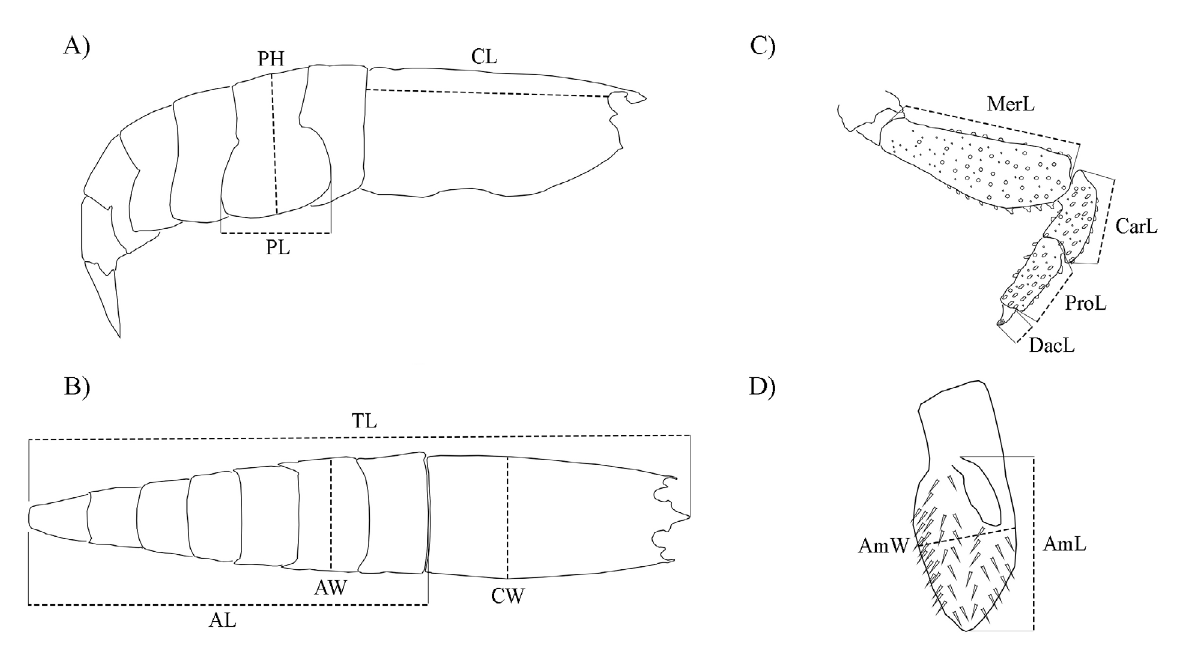
Figure 2. Dimensions used in the morphometric analyses of Atya Leach, 1816. A , (CL) carapace length, (PL) length of second abdominal pleuron, (PH) height of second abdominal pleuron; B , (CW) carapace width, (TL) total length, (AW) abdomen width, (AL) abdomen length; C , (MerL) merus length, (CarL) carpus length, (ProL) propodus length, (DacL) dactylus length; D , (AmL) length of male appendix interna, (AmW) width of male appendix